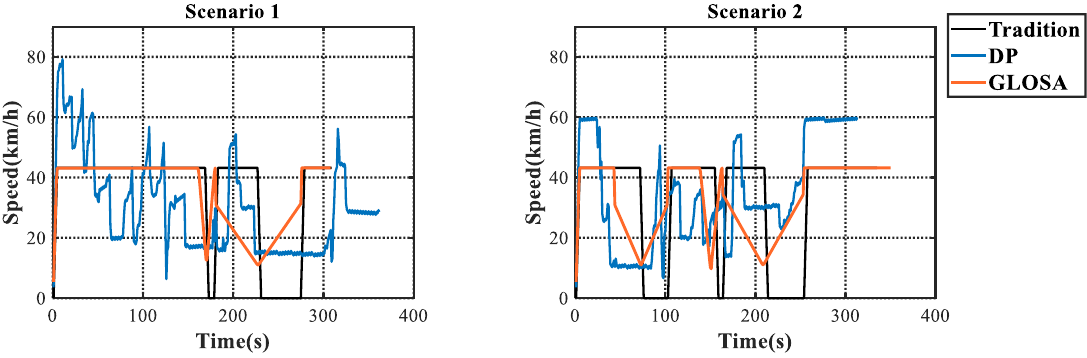
Figure 7. Time–speed curves of different scenarios. Figure 7. Time – speed curves of different scenarios. Figure 7. Time – speed curves of different scenarios.